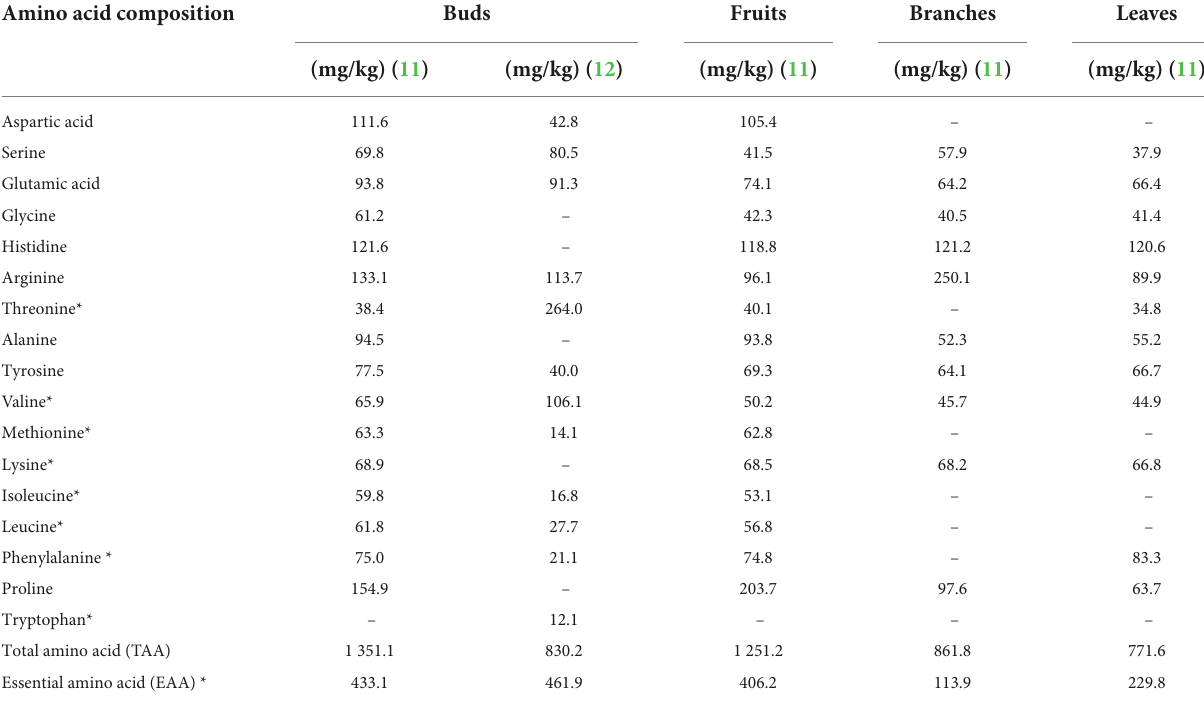
TABLE 4 Amino acid composition in various parts of S. aromaticum . Amino acid composition